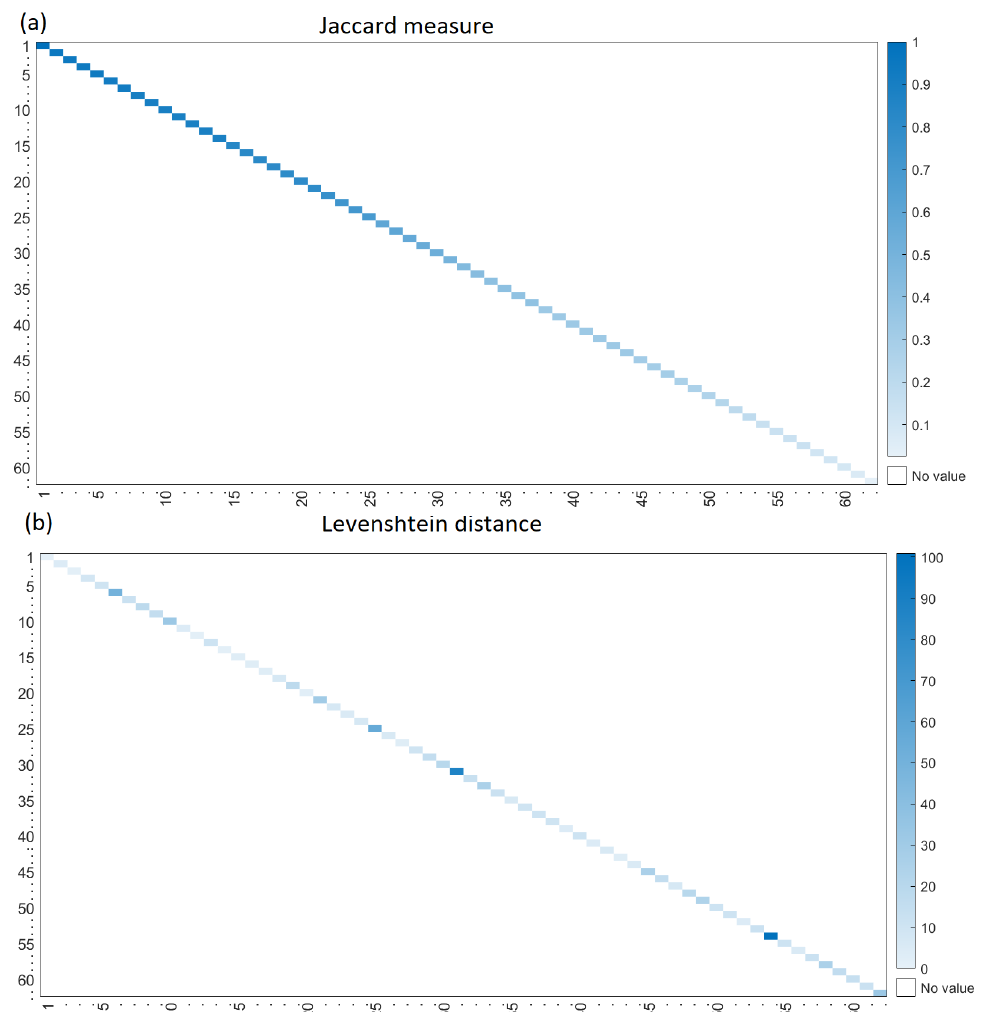
Figure 6. The ( a ) Jaccard measure and ( b ) the Levenshtein distance between the real and generated sequences of